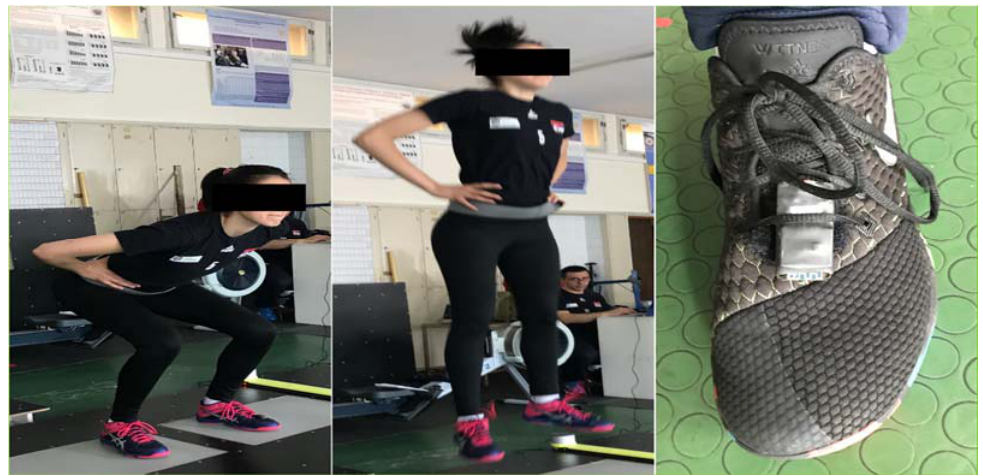
Figure 3. Squat jump — starting ( left ), take ‐ off/landing position ( middle ), and IMU placement ( right